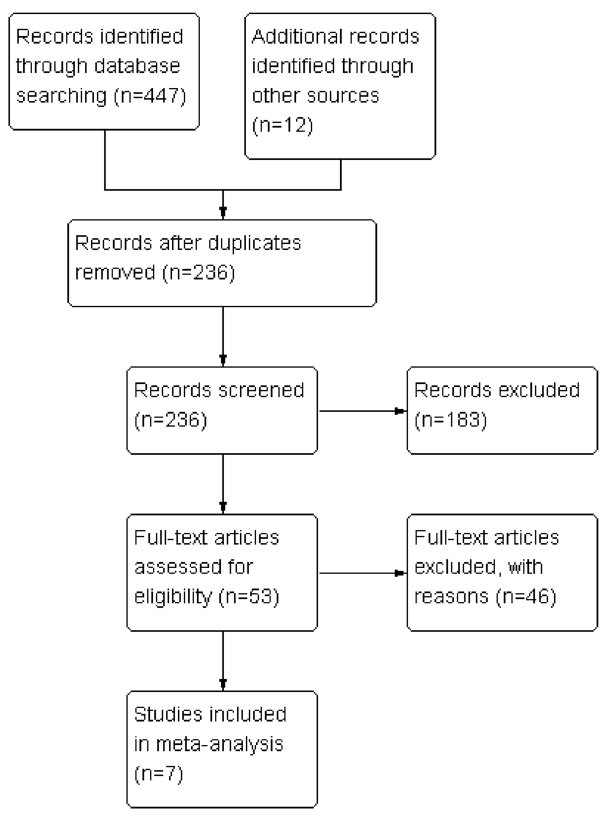
Figure 1. Flow diagram of study identification, inclusion, and